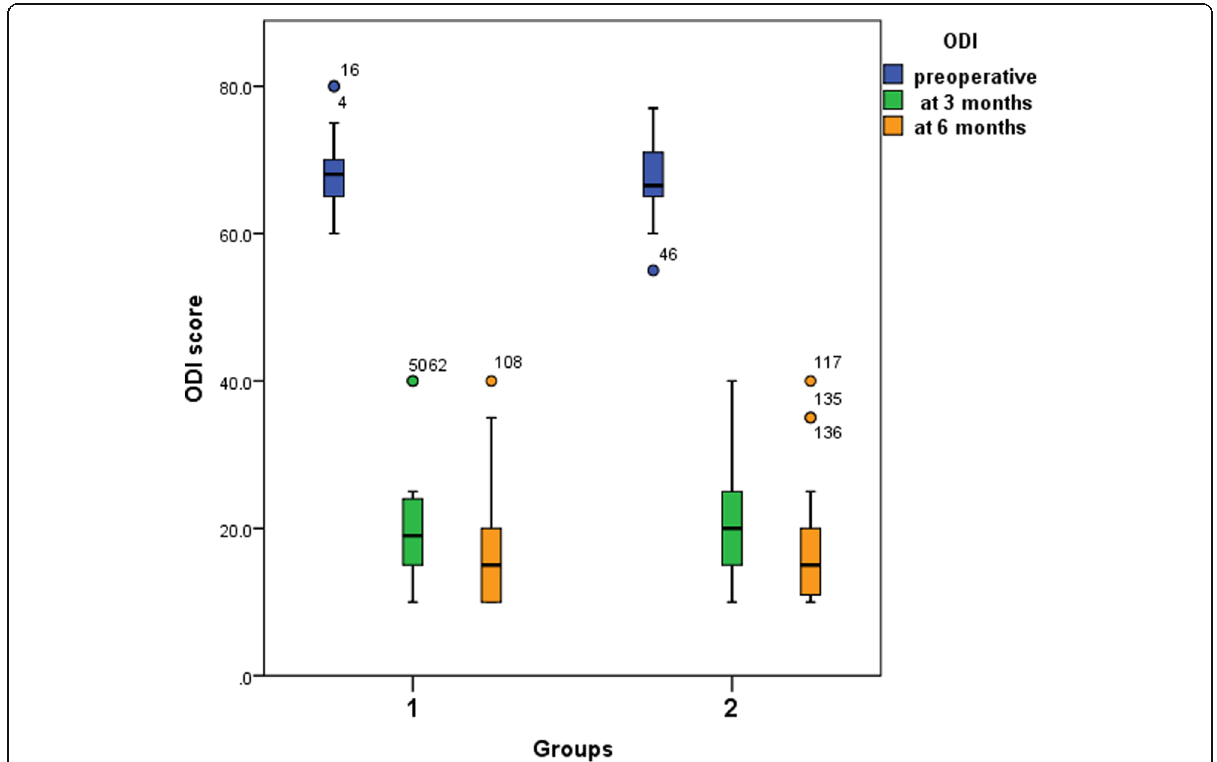
Fig. 4 Comparison of preoperative and postoperative ODI scores in the studied